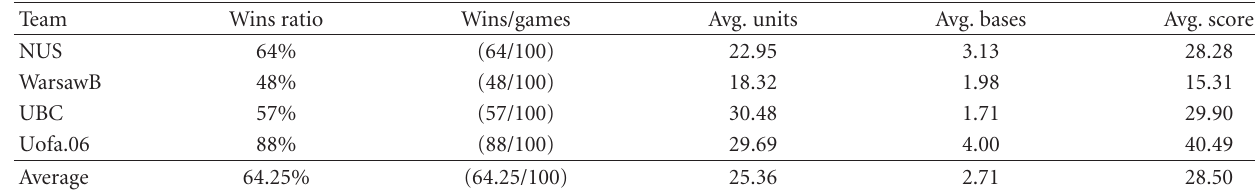
Table 4: Experiment results from defensive